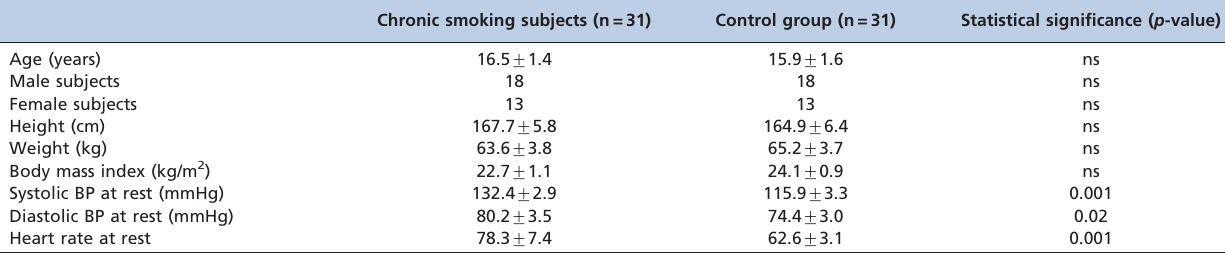
Table 1 - Clinical characteristics at